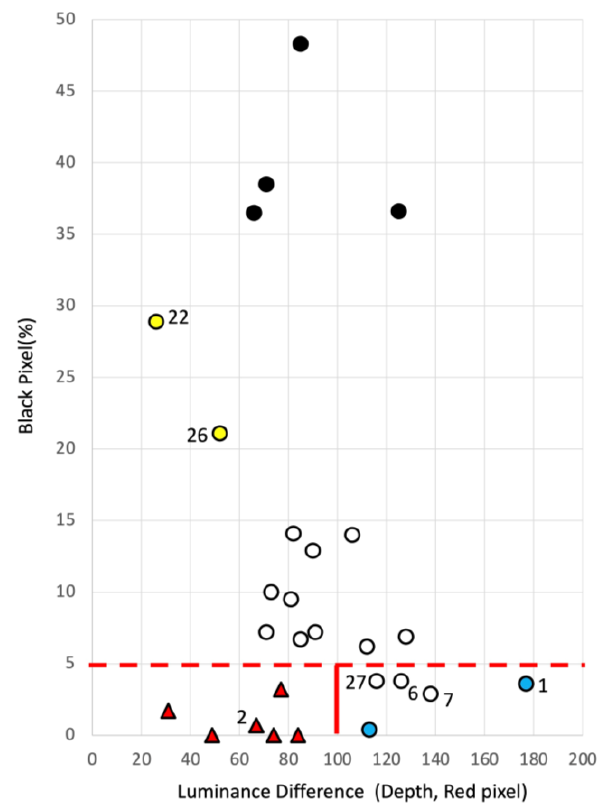
Figure 3. Twenty-seven cases aligned on the chart for detection of wound depth. The 27 cases were placed on a scatter plot with luminance difference on the horizontal axis and black pixels on the vertical axis. The 27 cases analyzed were divided into five groups: a shallow wound group with no necrosis (red triangle), slough group (yellow circle), black necrosis group (black circle), white necrosis group (white circle), and deep wound group with no necrosis (blue circle), according to physician judgment. In the case of the no necrosis group with less than 5% black pixels, the threshold line was created with a difference of brightness of 100, with “ shallow wounds ” distributed below 100 and “ deep wounds ” above 100. The “ shallow wounds ” were distributed below 100, whereas the “ deep wounds ” were distributed above 100. The slough group was distributed between 20% and 30% black pixels. Table 4. The result of determination of wound depth ( n = 27) with medical specialists vs. image identification algorithm.